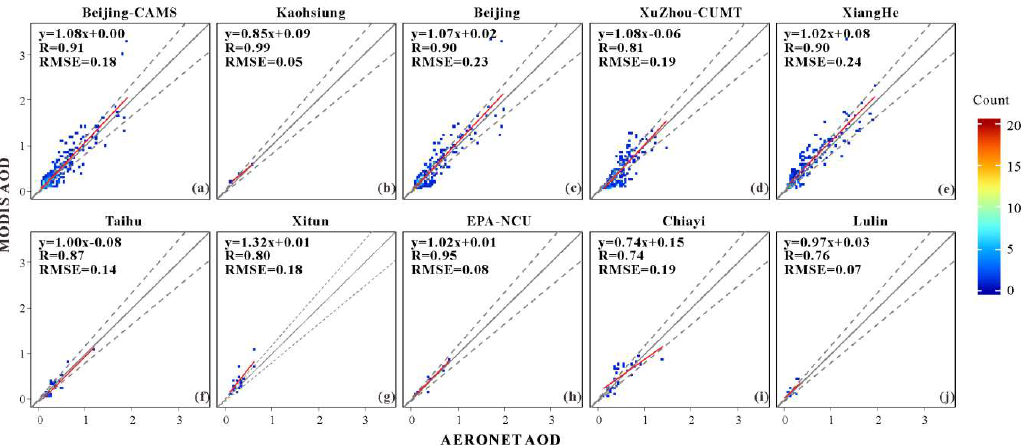
Figure 5. MODIS AOD retrievals against AERONET AOD values at 500 nm for 10 sites (Beijing-CAMS ( a ), Kaohsiung ( b ), Beijing ( c ) XuZhou-CUMT ( d ), XiangHe ( e ), Taihu ( f ), Xitun ( g ), EPA-NCU ( h ), Chiayi ( i ) and Lulin ( j )) with valid collocations.